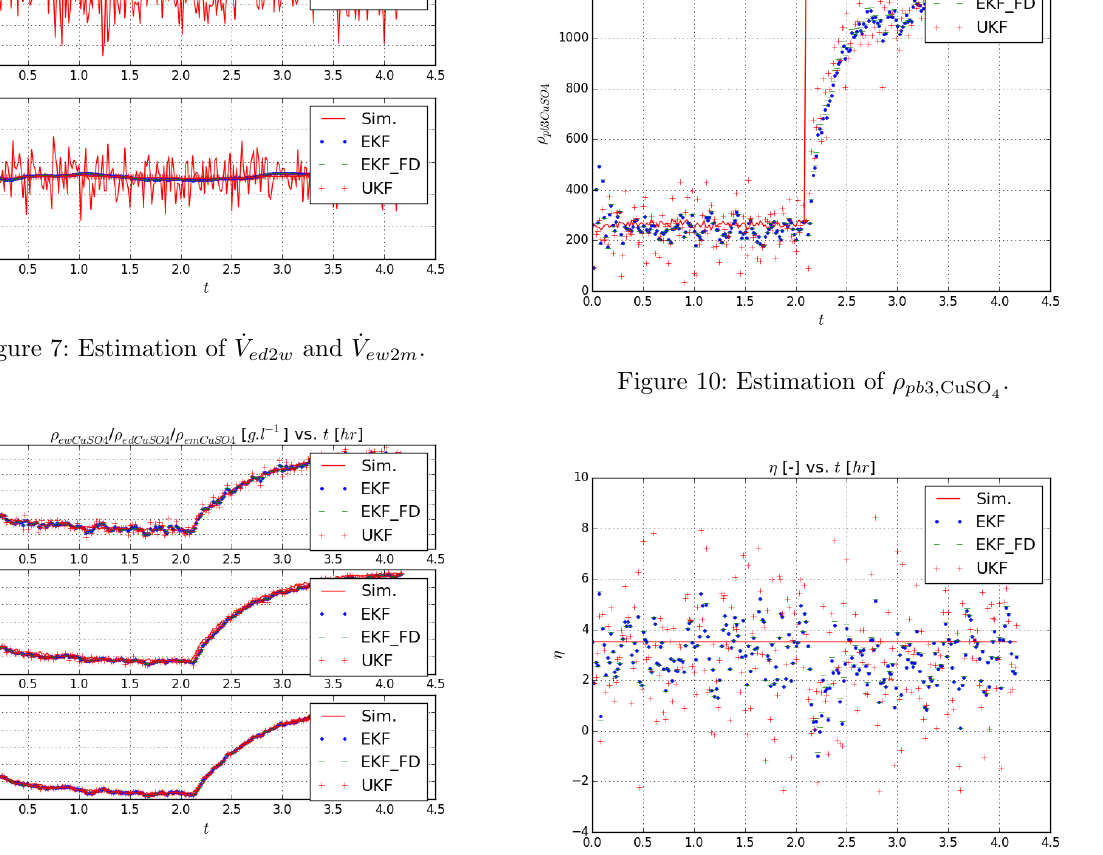
Figure 8: Estimation of ρ ew, CuSO ρ em, CuSO . 4